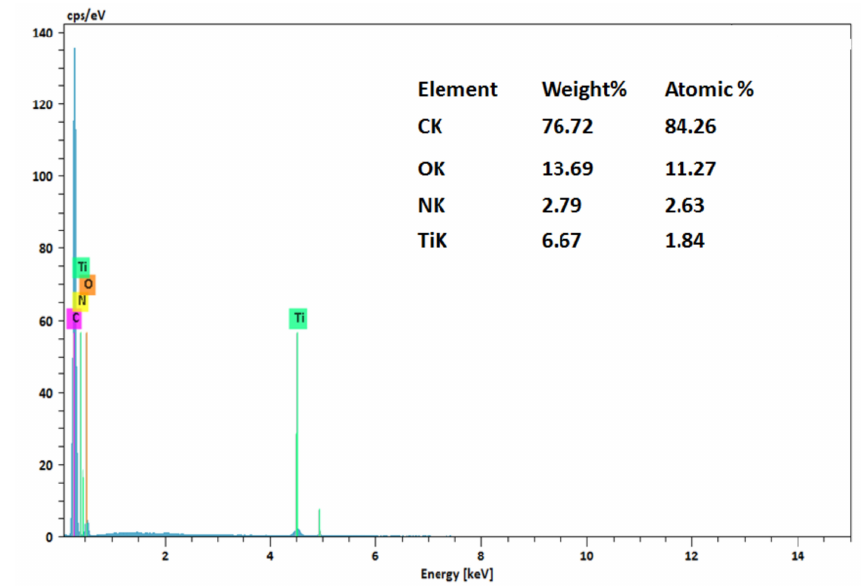
Figure 4. EDX spectrum of AC/TiO 2 -b